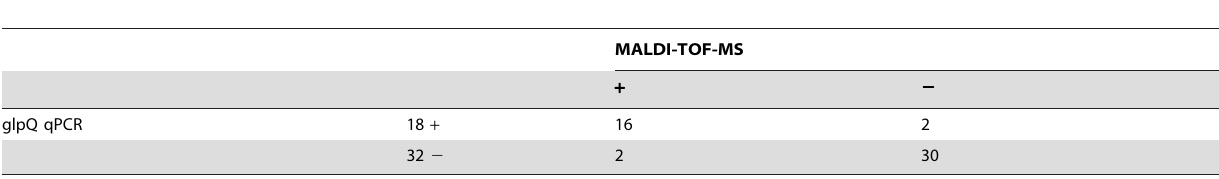
Table 2. MALDI-TOF-MS detection of B. crocidurae in 50 O. sonrai ticks collected in Senegal.